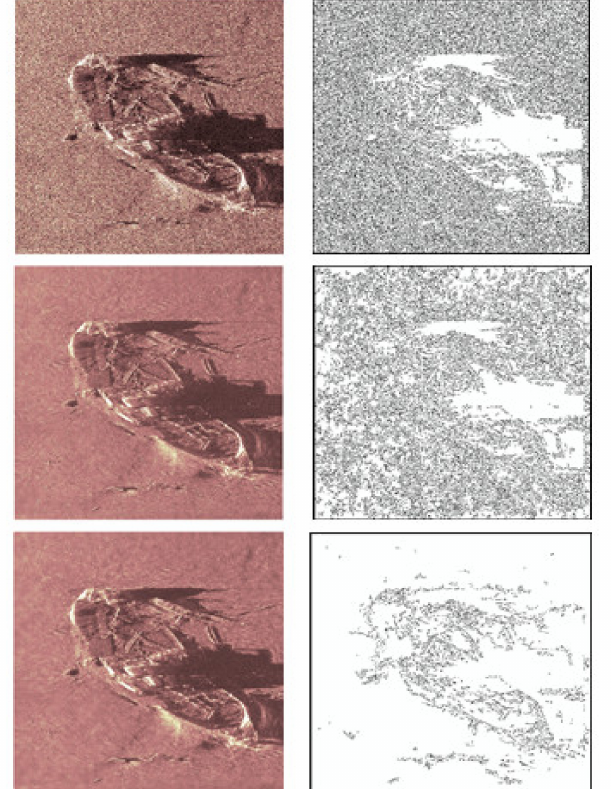
Figure 10. Results of the proposed edge detection method applied to a SONAR image. We are grateful to GESMA for making this image available to us. Left column: original image (up); first stage’s denoising result (middle); final denoising result (down). Right column: edge maps of corresponding images obtained applying the Canny’s